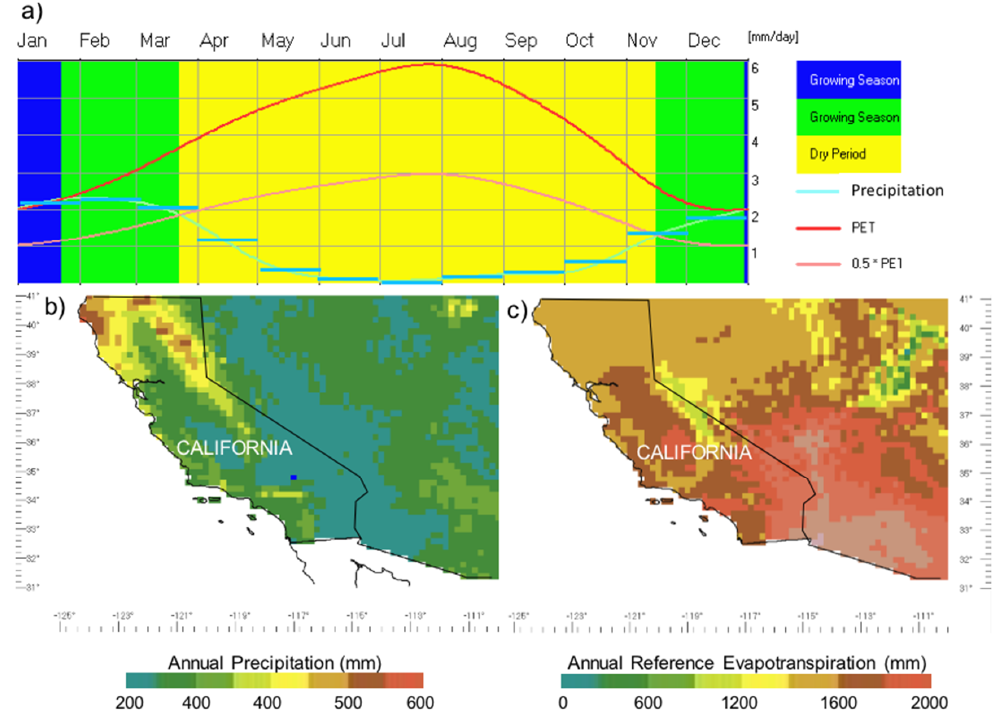
Figure 2. ( a ) Rainfall monthly regime with relative bioclimatic patterns for California; ( b ) mean annual smoothed 20-km spatial precipitation over the period 1961–1990; ( c ) the corresponding annual reference evapotranspiration (arranged via LocClim FAO software, http://www.fao.org/land-water/land/land-governance/land-resources-planning-toolbox/category/details/en/c/1032167).